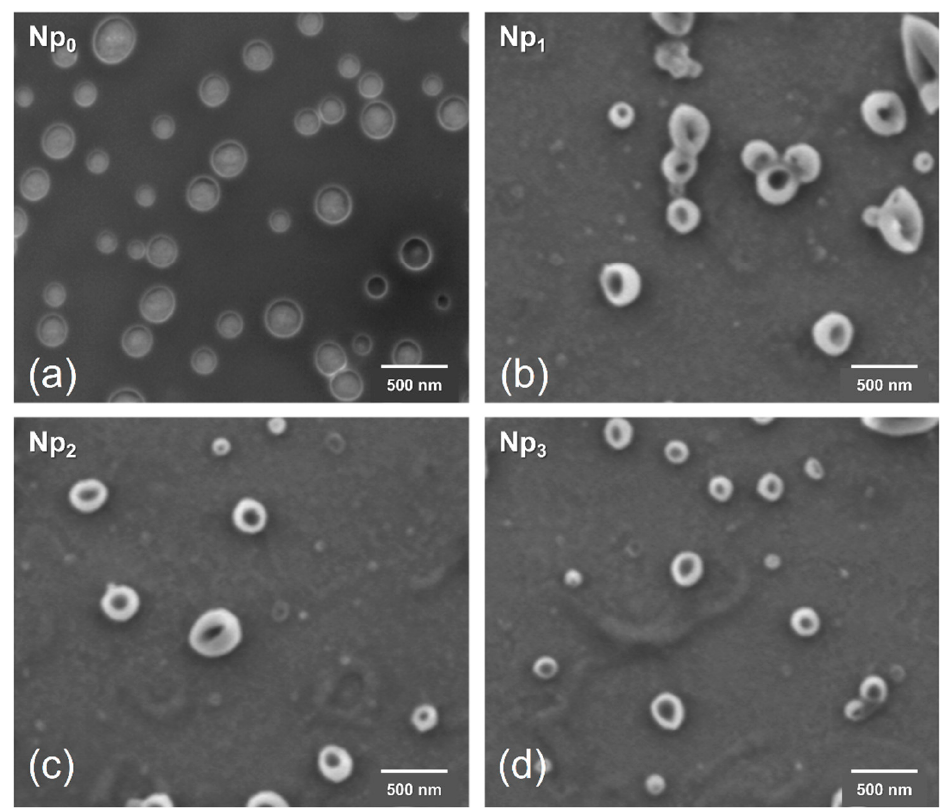
Figure 6. The behavior of size averages as a function of CS concentration. SEM imagen for ( a ) Np 0 ; ( b ) Np 1 ; ( c ) Np 2 and ( d ) Np 3 samples (scale bar = 500 nm).